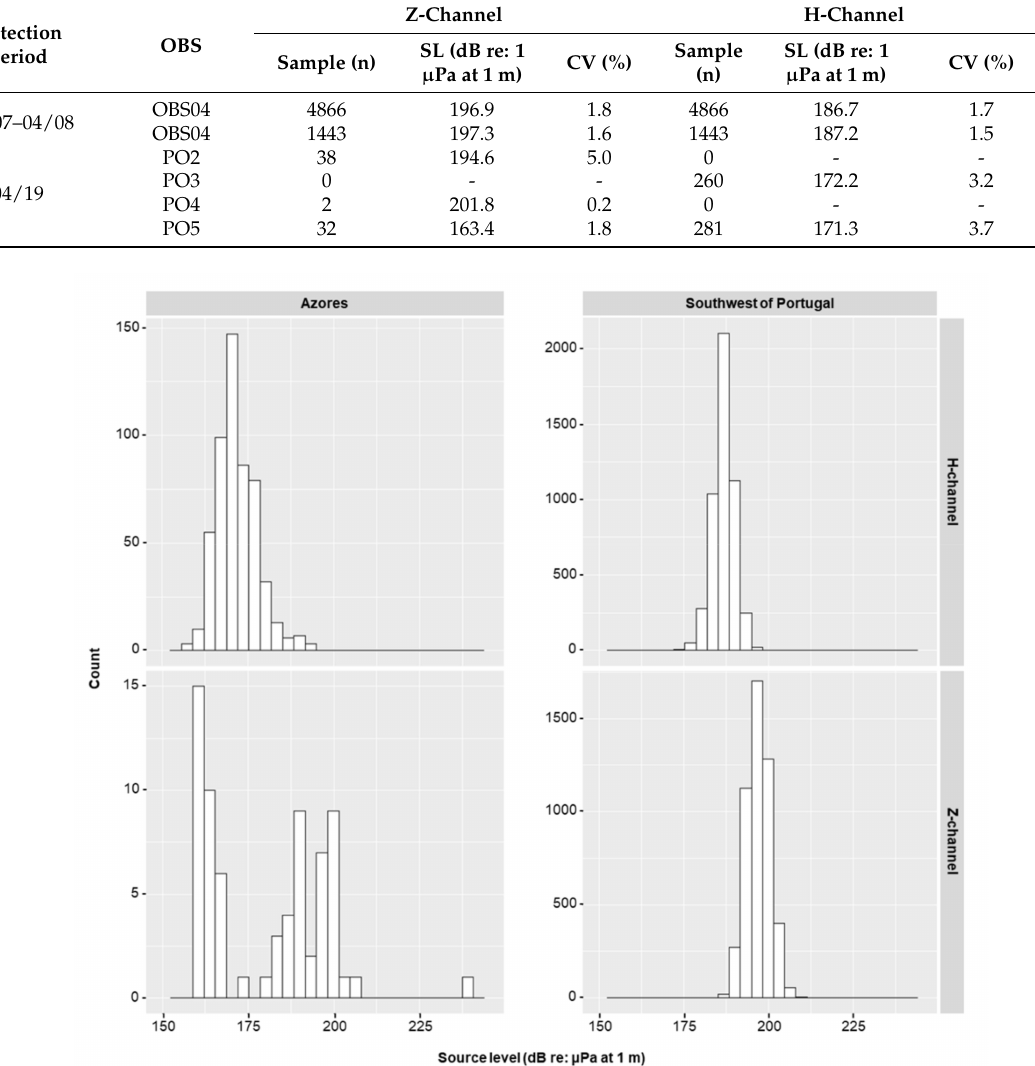
Figure 3. Distribution of estimated source levels from 20 Hz fin whale notes manually detected in the H-channel ( top ) and the Z-channel ( bottom ) of three OBS in the Azores ( left ) and one OBS in southwest Portugal ( right ). Estimated source levels for the Z-channel of PO4 were not included because of the small sample